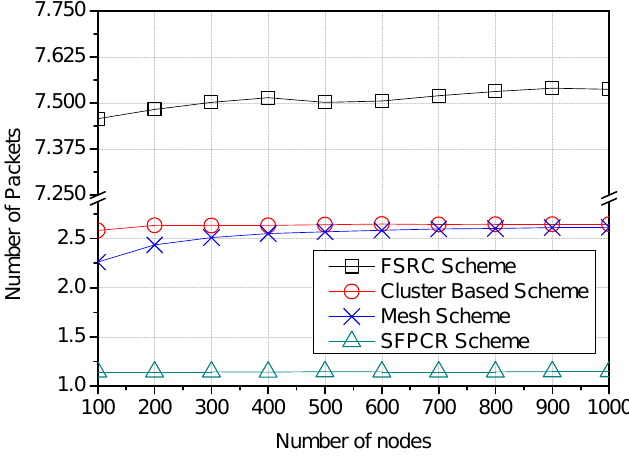
Figure 11. Variation in the number of packets according to the number of nodes in the network with a comparison between the proposed SFPCR scheme and other protocols.